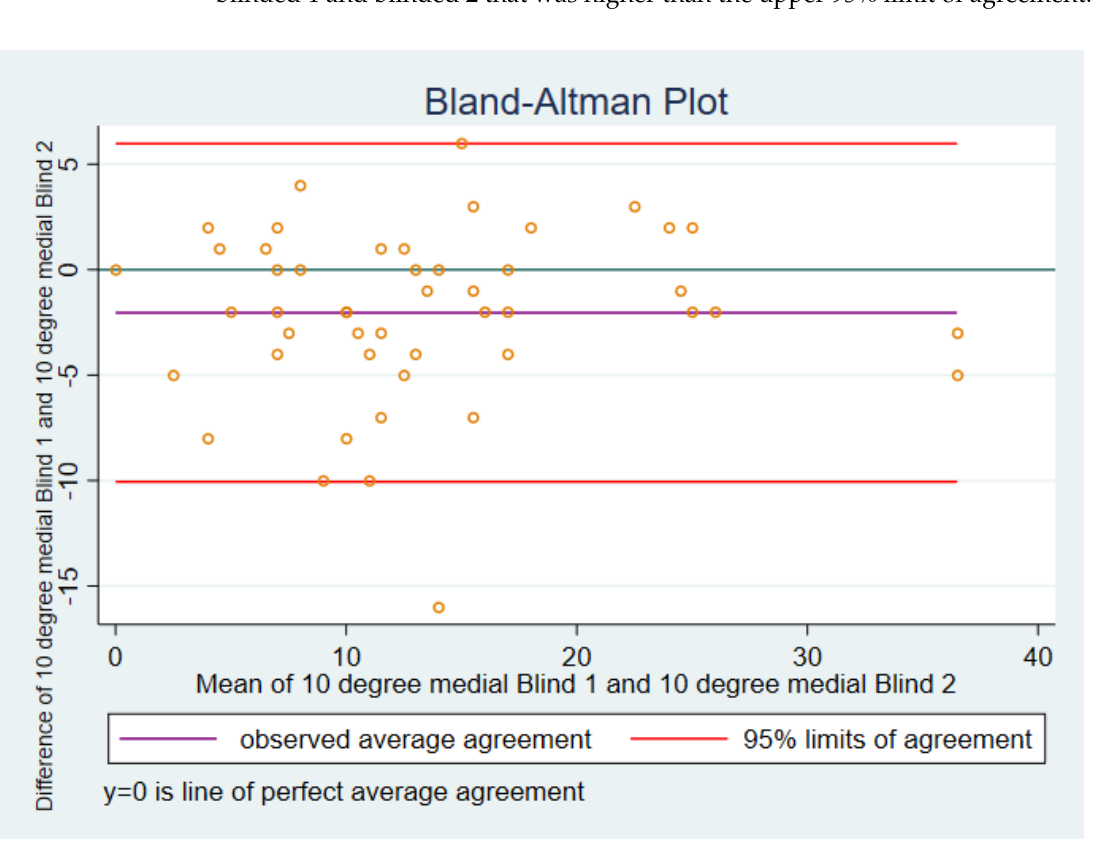
Table 1. Bland – Altman summary statistics for Scenario A. Table 1. Bland–Altman summary statistics for Scenario